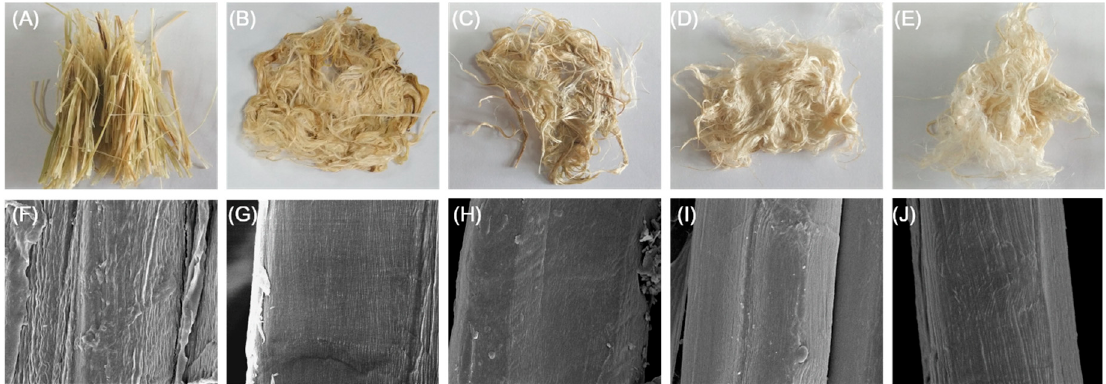
Figure 10. Ramie fibers treated with buffer (50 mM sodium glycine buffer, pH 9.0, negative control) ( A , F ); chemically (0.5% w / v sodium hydroxide ( B , G ), or 1% w / v sodium hydroxide ( C , H )); enzymatically (1 U/mL PpPel10a) ( D , I ); or with enzyme-chemical combination (1 U/mL PpPel10a and 0.5% w / v sodium hydroxide) ( E , J ). Images A – E : extrinsic features of ramie fibers; images F – J : scanning electron microscopy images of single fibers (5000×).